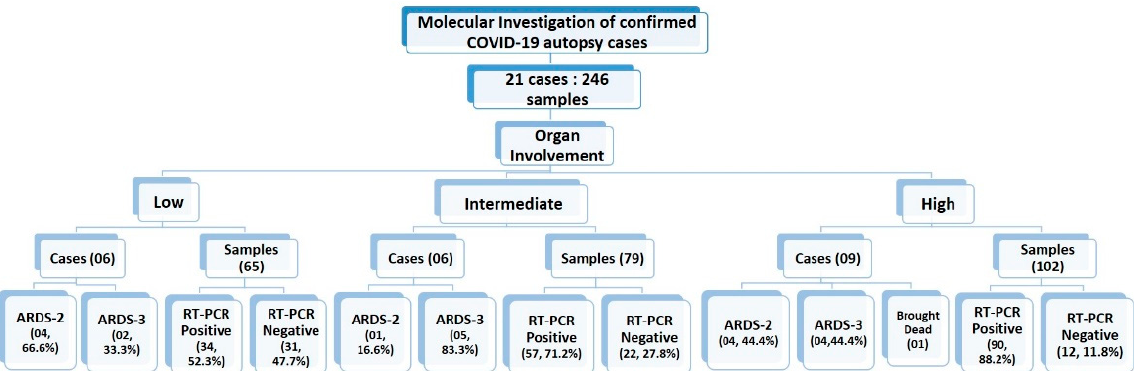
Figure 7. Summarizing the study cases and samples classification based on organ involvement, RT-PCR status and ARDS categories.